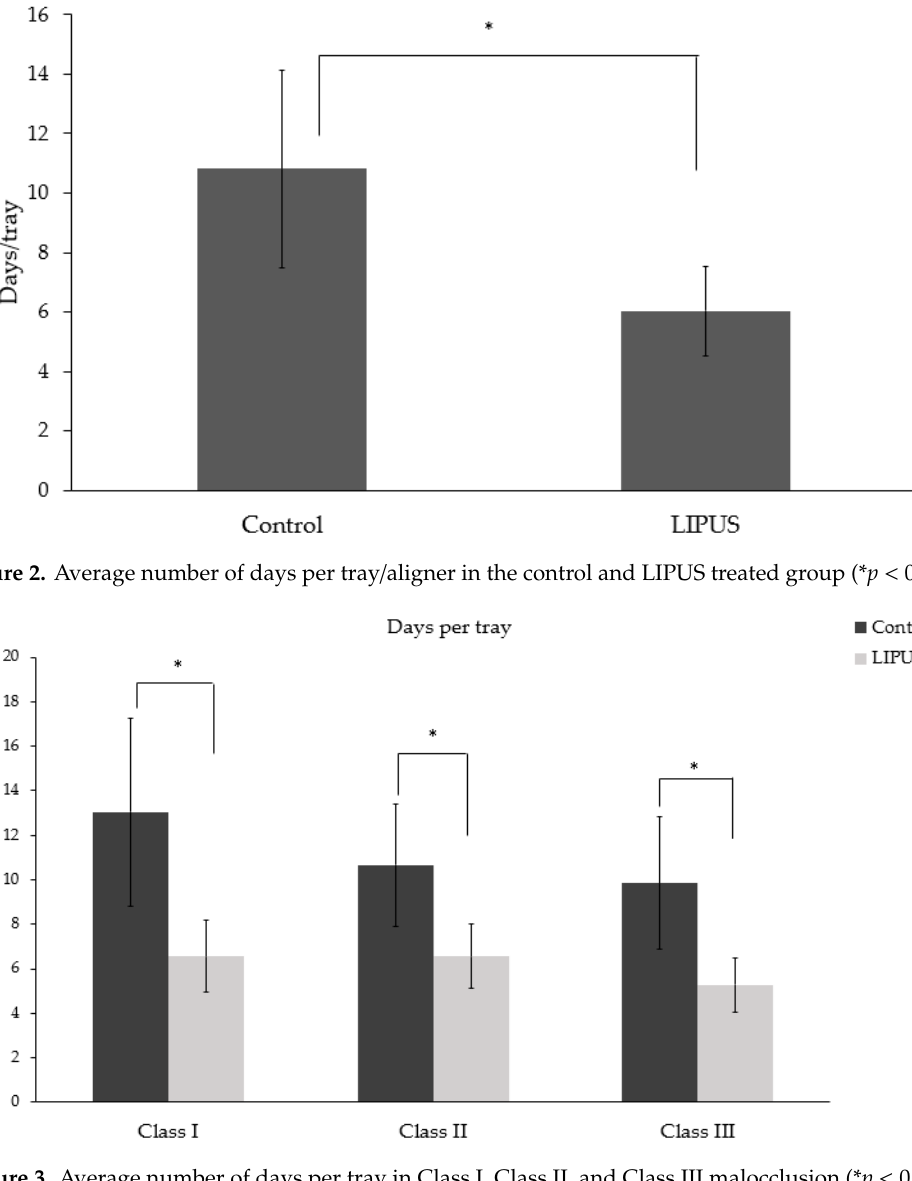
Figure 3. Average number of days per tray in Class I, Class II, and Class III malocclusion (* p < 0.05).